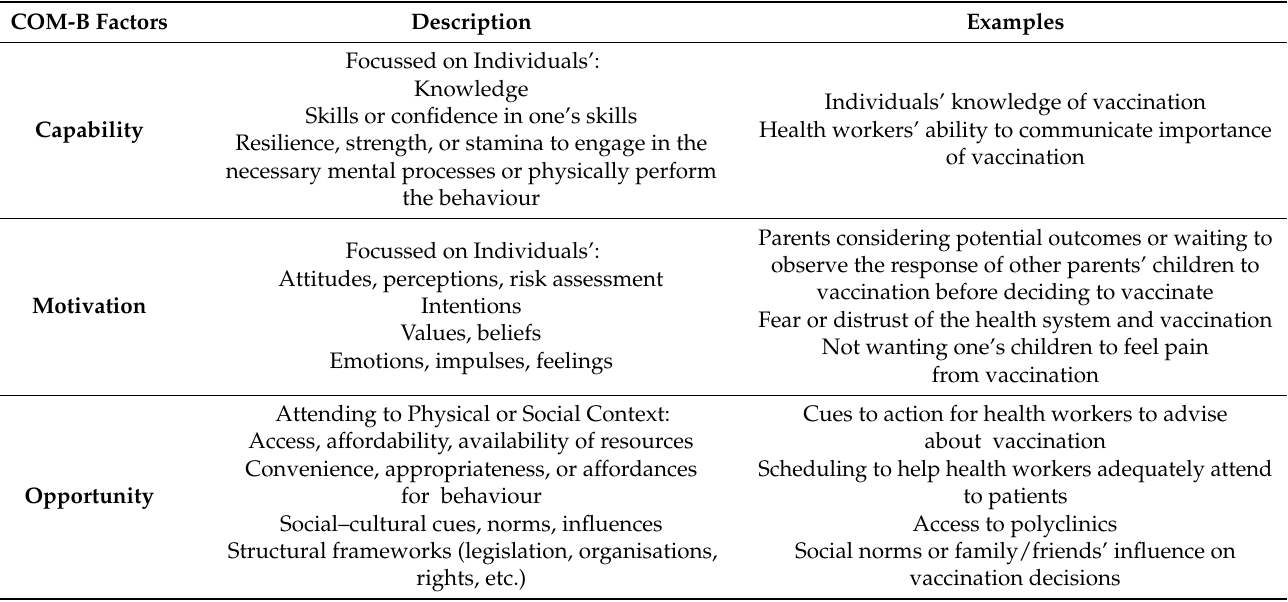
Table 1. COM-B Factors with